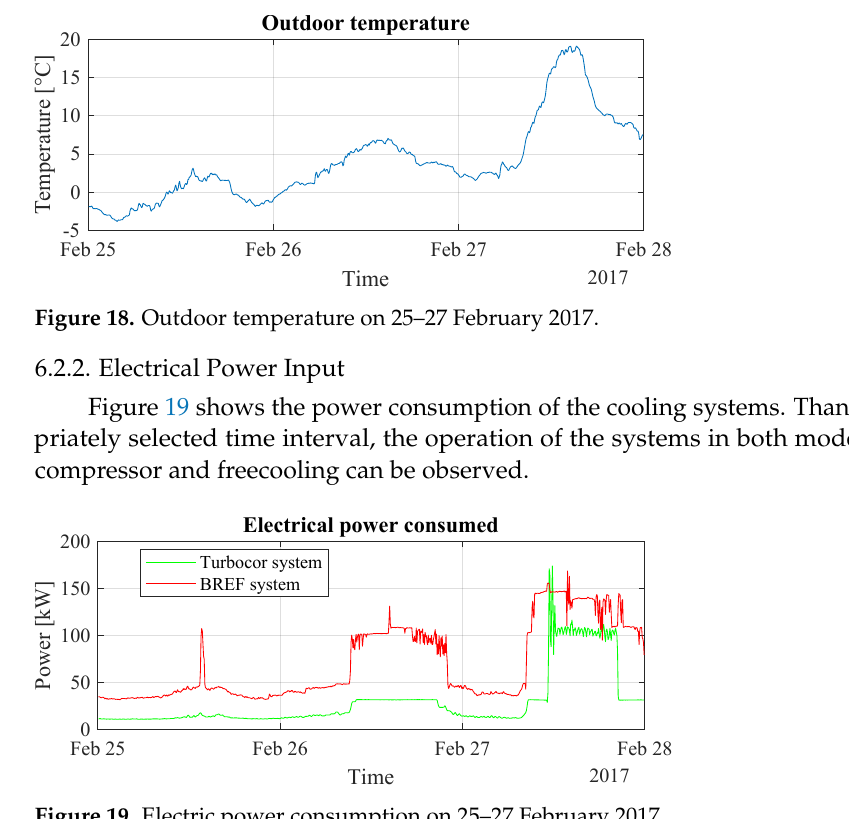
Figure 19. Electric power consumption on 25–27 February 2017.